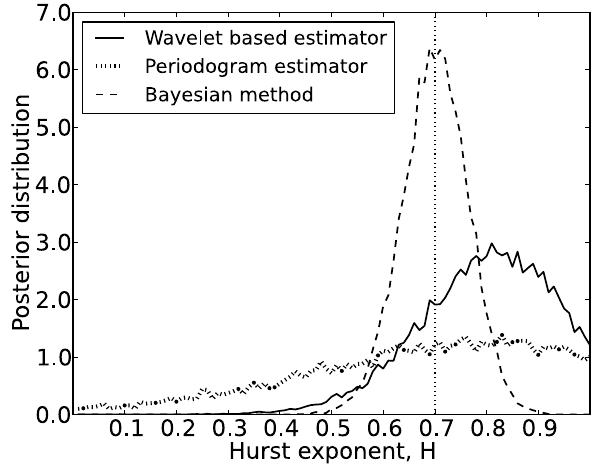
Fig. 3. The distribution of the estimator of the Hurst exponent for H = 0 . 7 ,N = 128 with 20 000 realizations by wavelet based esti- mator (solid line), periodogram method (dotted line) and Bayestian method (dashed line).